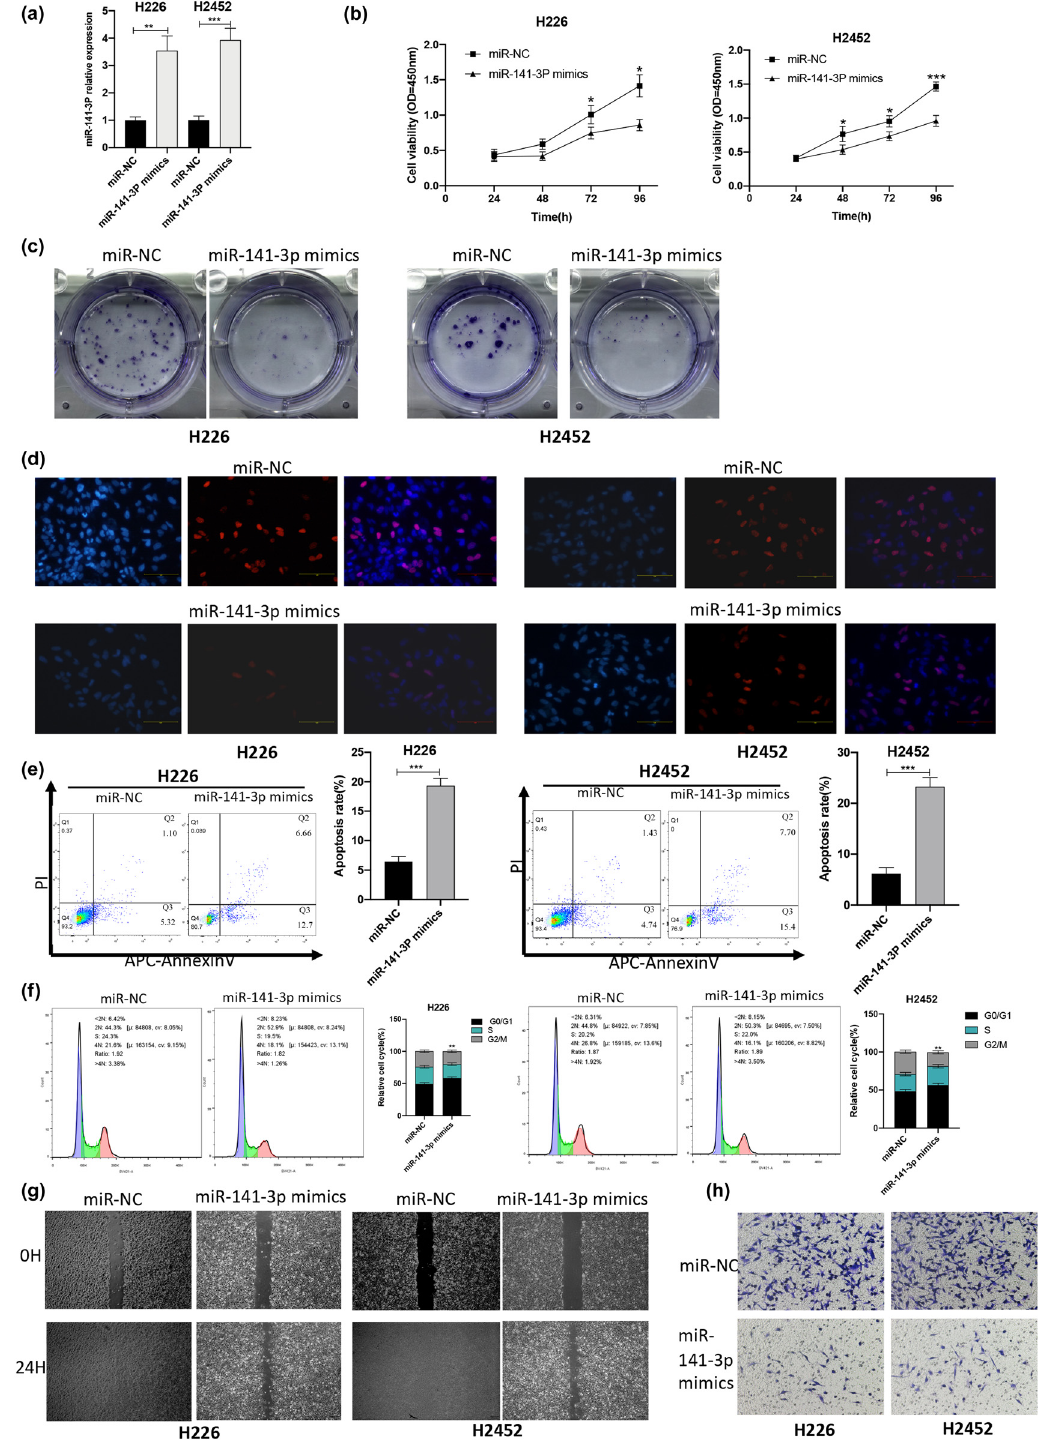
Figure 4: Overexpression of miR - 141 - 3p inhibits proliferation, migration, and invasion of MPM cells, and induces the cell apoptosis. ( a ) The RT - qPCR showed that the expression of miR - 141 - 3p in the miR - 141 - 3p mimics group was higher than that in the miR - NC group ( ** P < 0.01, *** P < 0.001, t - test ) . ( b ) The e ff ect of miR - 141 - 3p mimics on the cell viability was detected by CCK - 8 ( * P < 0.05, *** P < 0.001, t - test ) . ( c ) The in fl uence of miR - 141 - 3p mimics on the cell proliferation was assessed by colony formation assay. ( d ) The e ff ect of miR - 141 - 3p mimics on the cell proliferation was evaluated by EdU assay. ( e ) The in fl uence of miR - 141 - 3p mimics on the cell apoptosis was determined by fl ow cytometry ( *** P < 0.001, t - test ) . ( f ) Flow cytometry detected the e ff ect of miR - 141 - 3p mimics on the cell cycle progression ( ** P < 0.01, chi - square test ) . ( g ) The in fl uence of miR - 141 - 3p mimics on the cell migration was investigated by scratch test. ( h ) The e ff ect of miR - 141 - 3p mimics on the cell invasion was detected by Transwell invasion